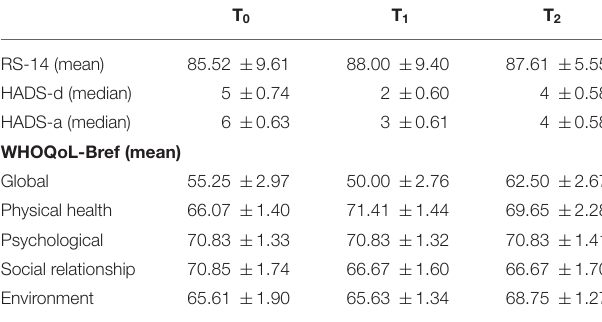
TABLE 1 | Socio-demographic and clinical characteristics. TABLE 2 | Psychological variables at T 0 , T 1 and T 2